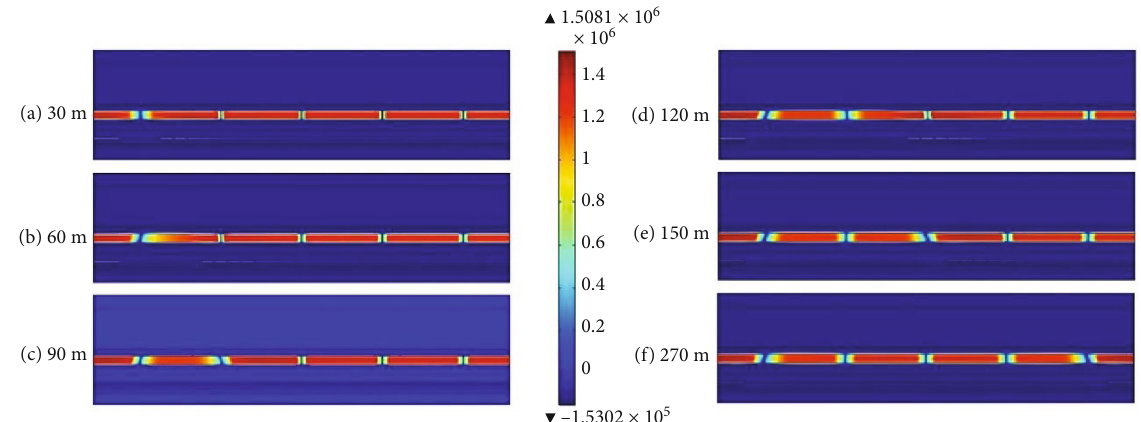
Figure 5: Scheme of gas pressure distribution of gas drainage with pressure-relief